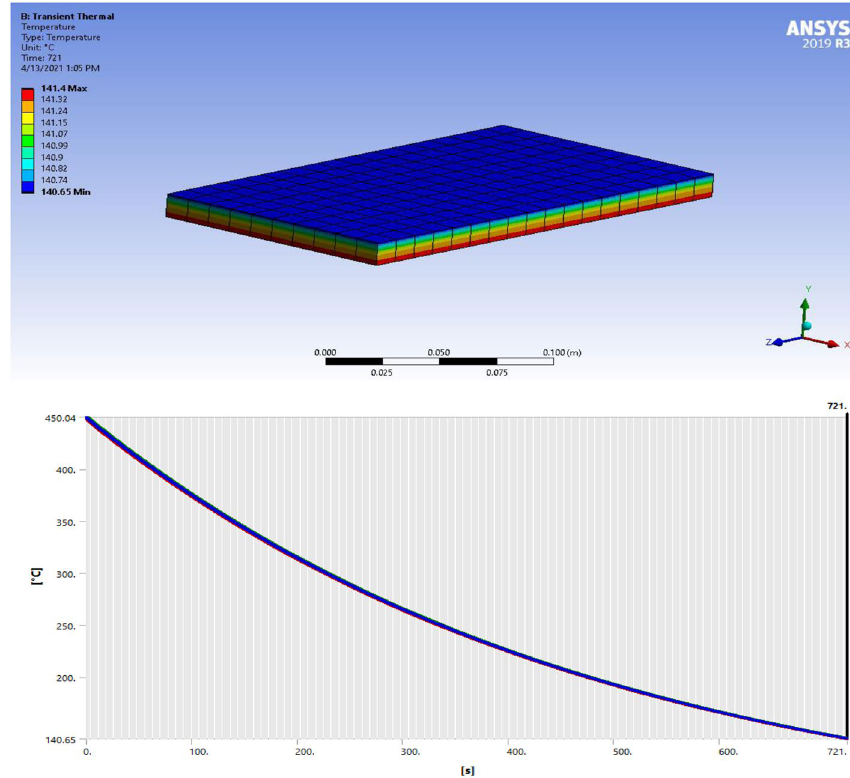
Fig. 12 CFD temp. controlled model and time plot at 150 °C, D